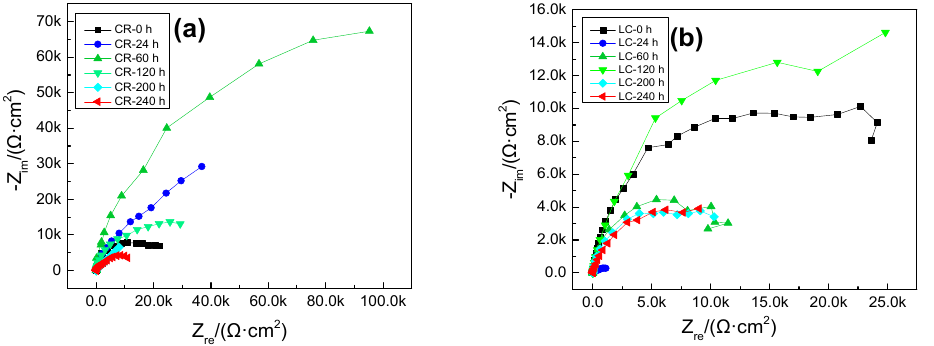
Figure 2. Nyquist plot at different corrosive duration times: ( a ) the CR bars; and ( b ) the LC bars.